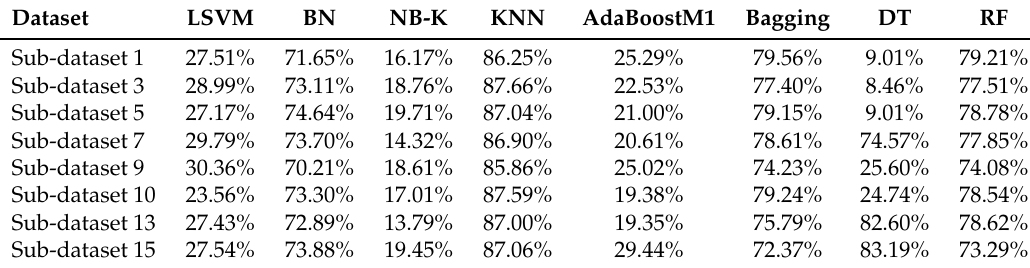
Table 4. Accuracy results under multi-class